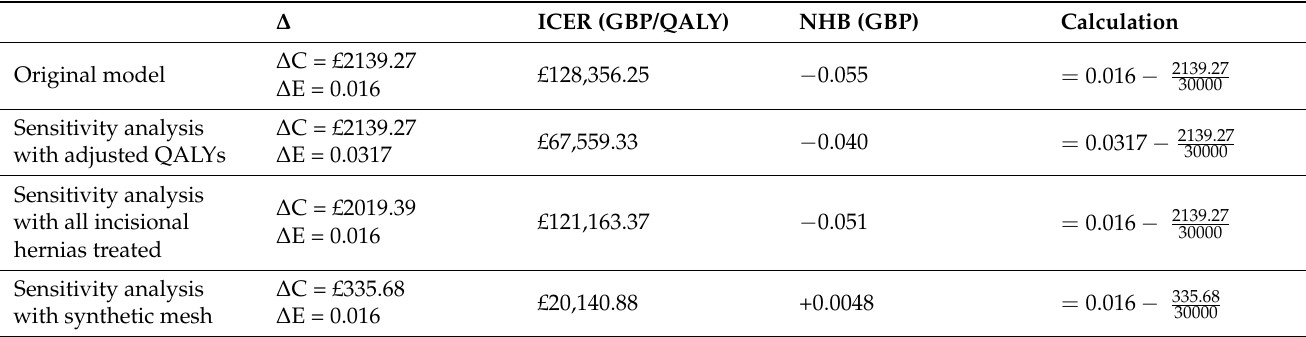
Table A10. NHB * calculations for the original model and the two sensitivity